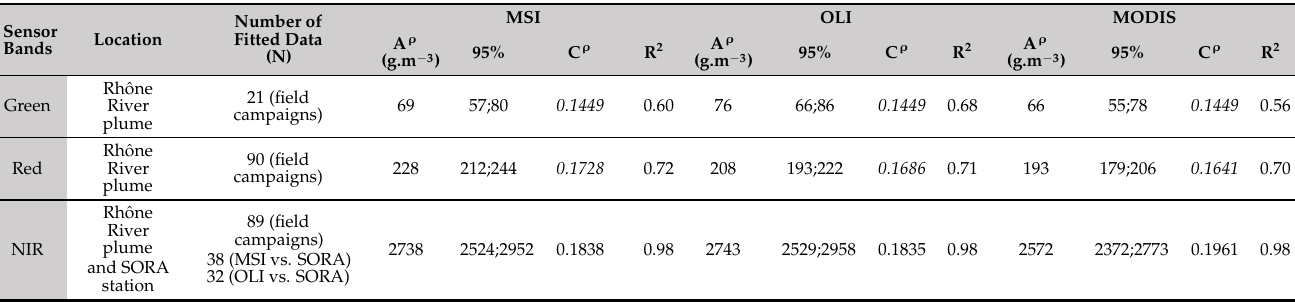
Table 2. Recalibrated Nechad ρ w vs. SPM relationship coefficients for the green, red, and NIR bands of the MSI, OLI, and MODIS sensors. The A ρ coefficient and its 95% confidence bounds as well as the C ρ coefficient for the NIR relationship were fitted on the data (Figure 3) while the C ρ coefficients for the green and red relationships were computed from the literature ( in italic